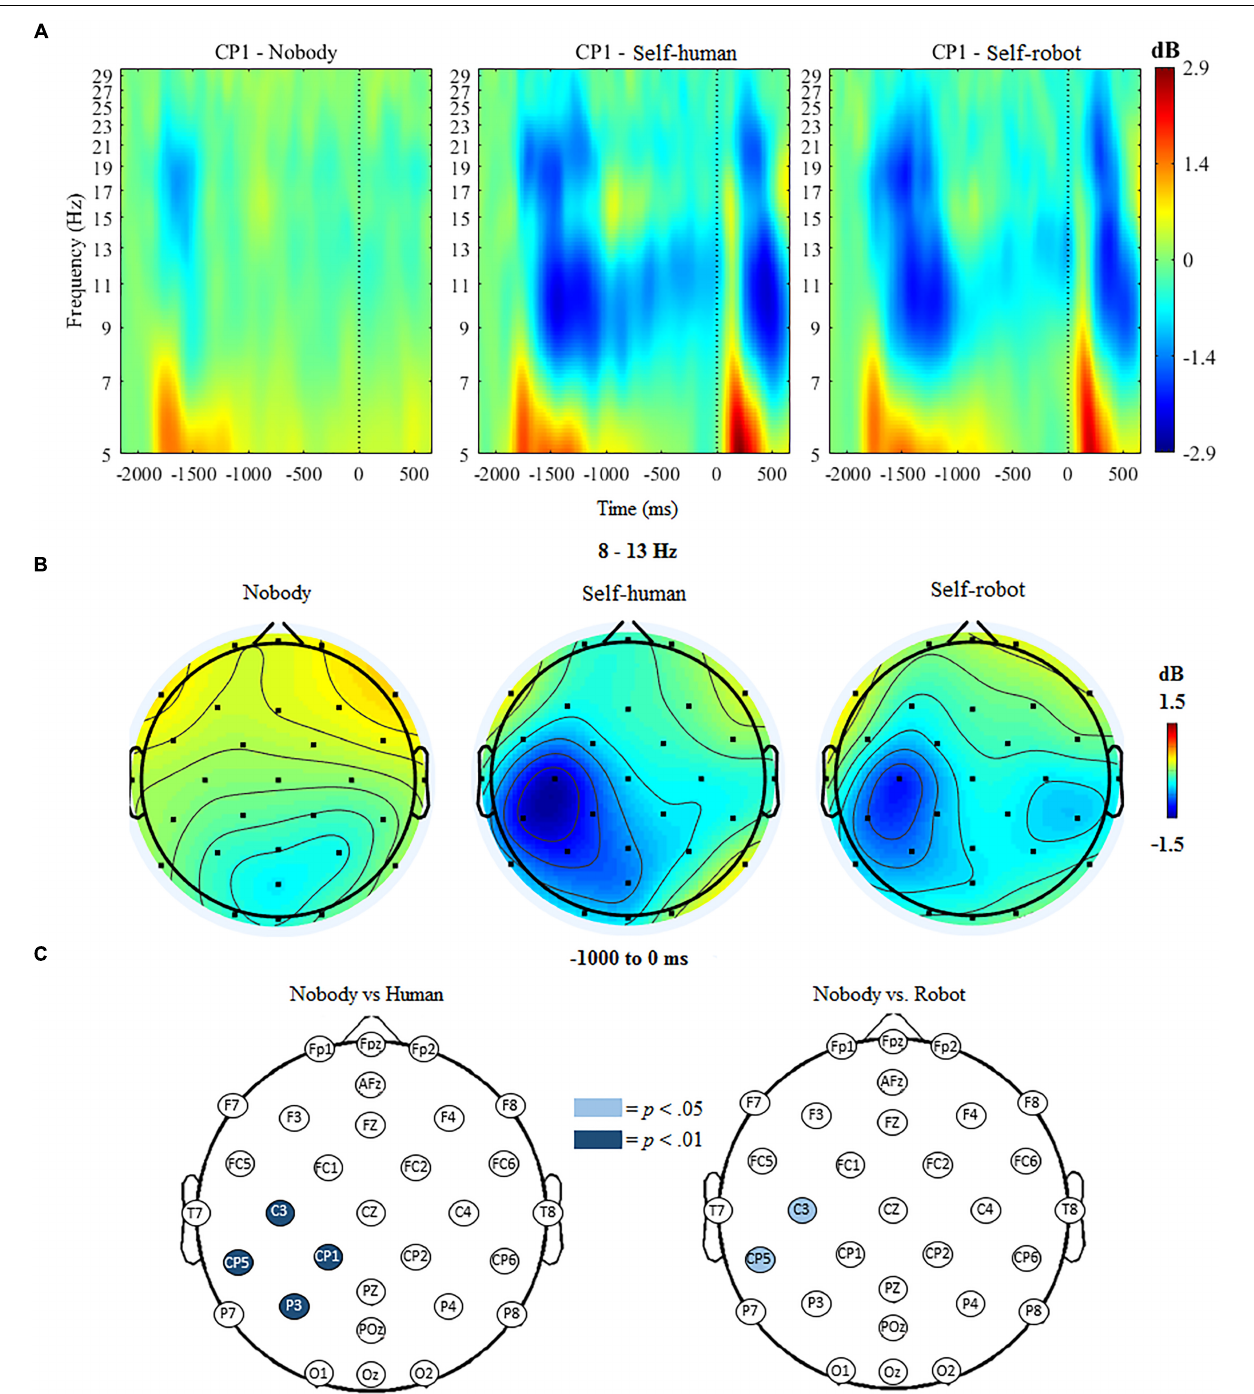
FIGURE 3 | (A) Event-related spectral perturbation (ERSP) at electrode CP1 during nobody trials and self trials (in human/robot conditions), with alpha ERD in the time window during tactile anticipation. (B) Topographic maps showing activity in the mu/alpha (8–13 Hz) band during anticipation of tactile stimulation across conditions. (C) Differences in 8–13 Hz desynchronization between nobody and human- self and nobody and robot- self trials, respectively. Significantly different electrodes are highlighted, showing differences in the mu rhythm over central sites based on paired samples t -tests. The nose is located at the top of the scalp